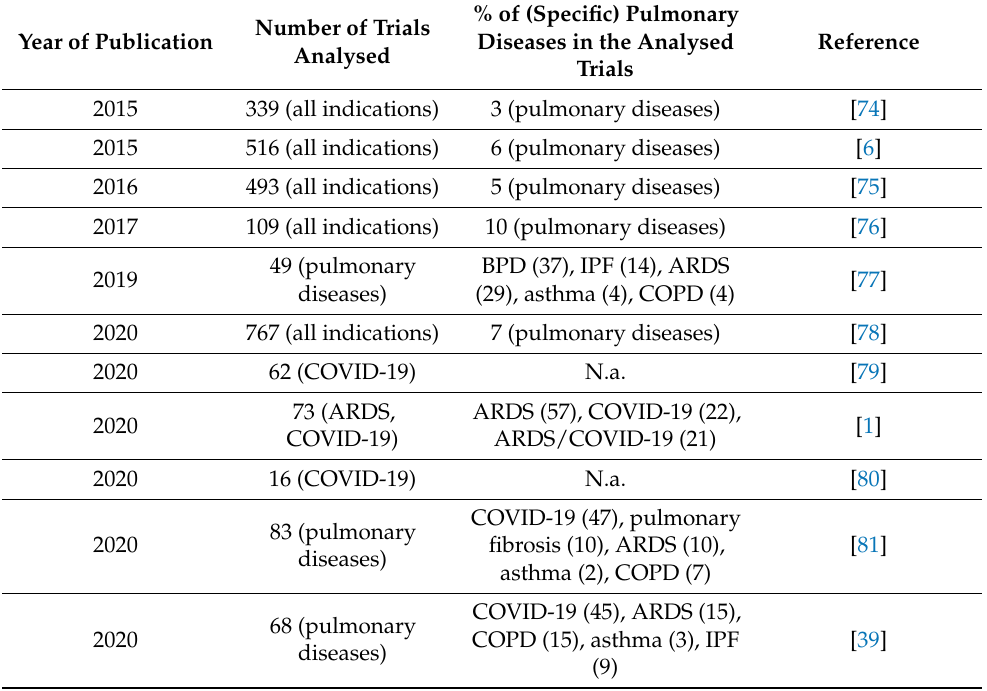
Table 2. Overview of clinical trials listing the fraction (%) of studies evaluating pulmonary diseases among all trials or the fraction of specific lung diseases, when only trials on pulmonary diseases were